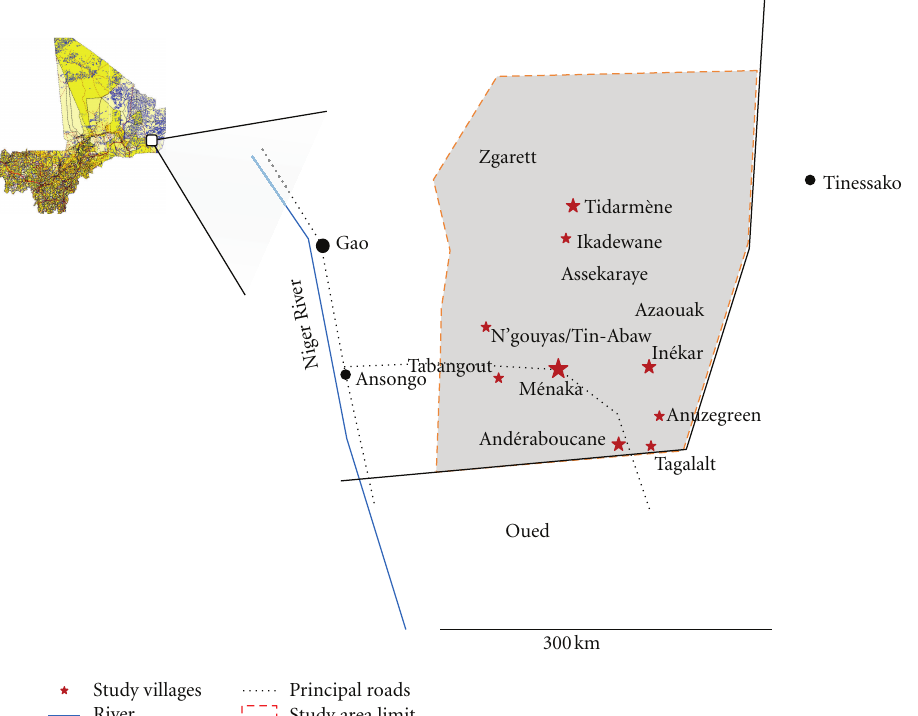
Figure 1: Map of study area. This map shows the 9 sites where the study was performed. And´eramboukane (has a permanent pond) and Talgalat (semipermanent pond, dry at the end of the year) are located near the border with the Republic of Niger (North of Mali). Tin-abaw and and N’gouyass separated by a permanent pound are located between M´enaka and And´eramboukane. Inekar and Anuzegreen that are also located between Menaka and And´eramboukane do not have ponds. Sites such as Tabangout (10km from M´enaka) and Tidarmane- Ikadewane that are situated in the south of M´enaka, do not have ponds. M´enaka, the capital city, has a semipermanent